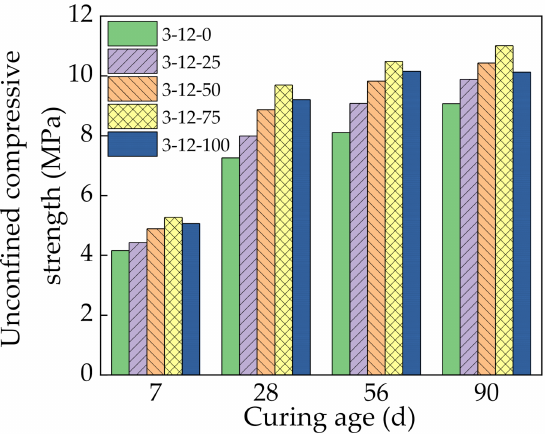
Figure 7. Unconfined compressive strength with different steel slag contents. The UCS increased only 6.4% at 25% SS. This is because SS has little effect on the strength of the mixture at low contents and cannot play a dominant role. The UCS of 100% SS was lower than 75% SS, which indicates that the SS content can be optimized. When the SS content was too high, the high porosity of SS increased the porosity of the specimen. Some cement was adsorbed and wrapped inside the surface pores of SS, which isolated water molecules and made them unavailable for hydration, which is not conducive to strength formation. In addition, the SS had a relatively high content of active substances, which resulted in excessive volume expansion after their reaction. The original pores of the mixture were not sufficient to absorb this volume expansion, which increased the internal stress. When the cumulative internal stress accumulation reached a certain level, some small cracks were generated in the mixture, which reduced the strength